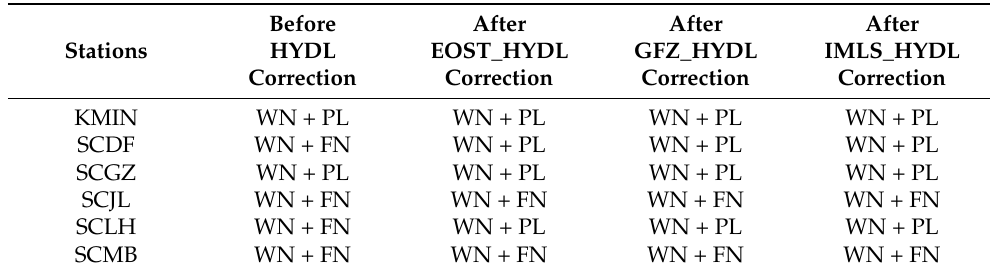
Table 1. The optimal noise model estimated from GNSS vertical time series before and